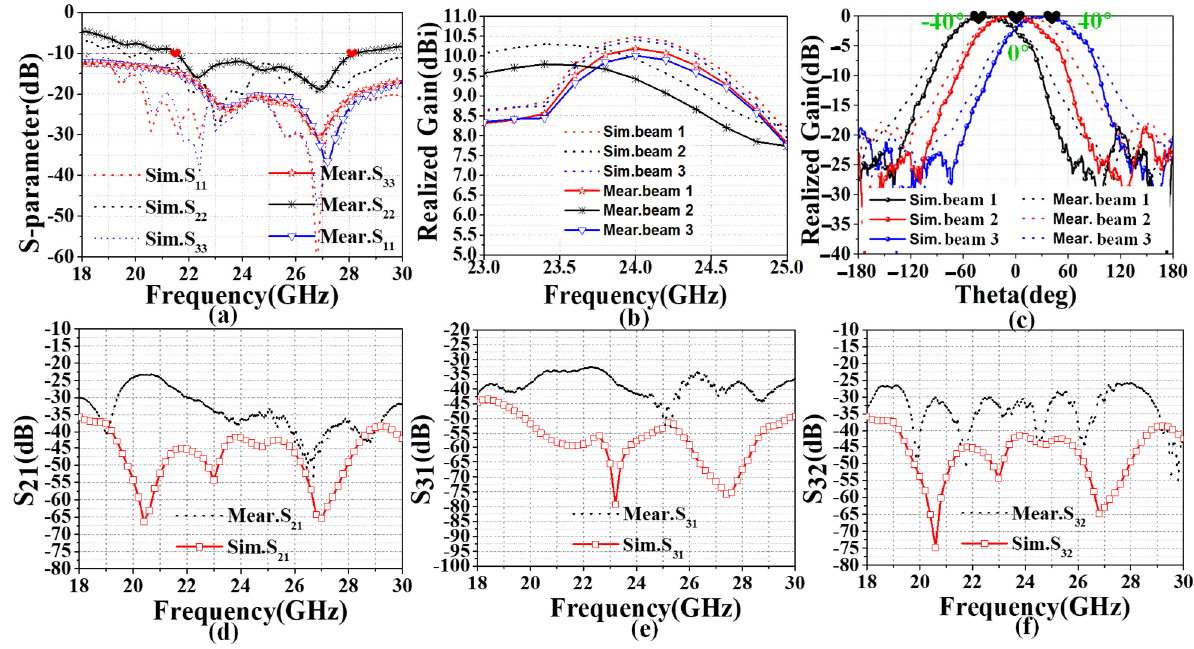
Figure 7. Normalized measured and simulated results for the CGF conformal antenna with the radii of 30 mm; ( a ) S-parameter of the CGF antenna; ( b ) realized gains; ( c ) the main lobe direction; ( d ) mutual coupling of ant1 and ant2; ( e ) mutual coupling of ant1 and ant3; ( f ) mutual coupling of ant2 and